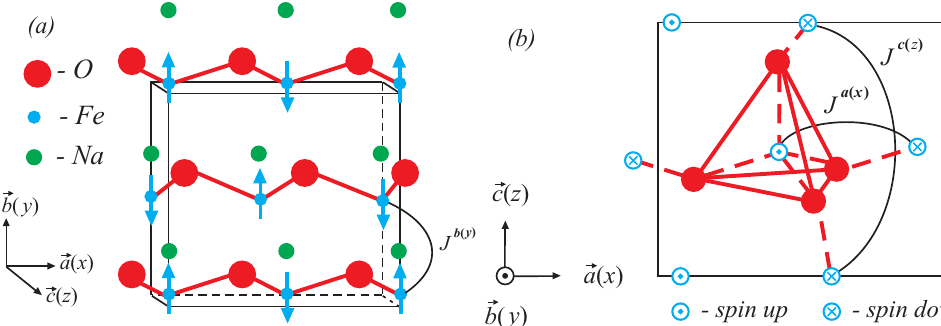
Figure 1. Scheme of the structure ( a ) and the magnetic interactions ( b ) of β